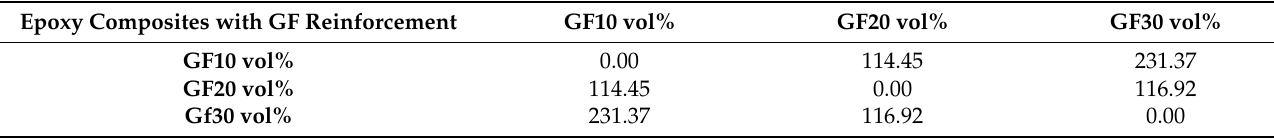
Table 3. HSD as measured by Tukey’s test for the Izod absorbed impact energy of epoxy composites with different volume fractions of guaruman